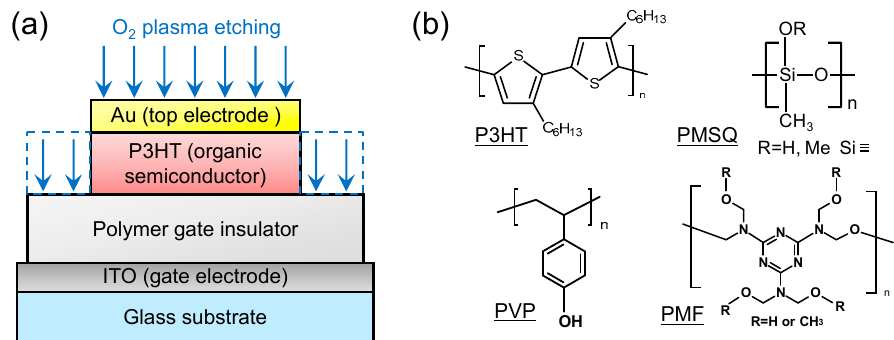
Figure 1. ( a ) Schematic cross section of the organic MIS capacitor after O 2 plasma etching. The dotted squares represent the peripheral regions removed by etching. ( b ) Chemical structures of organic materials used in this study.